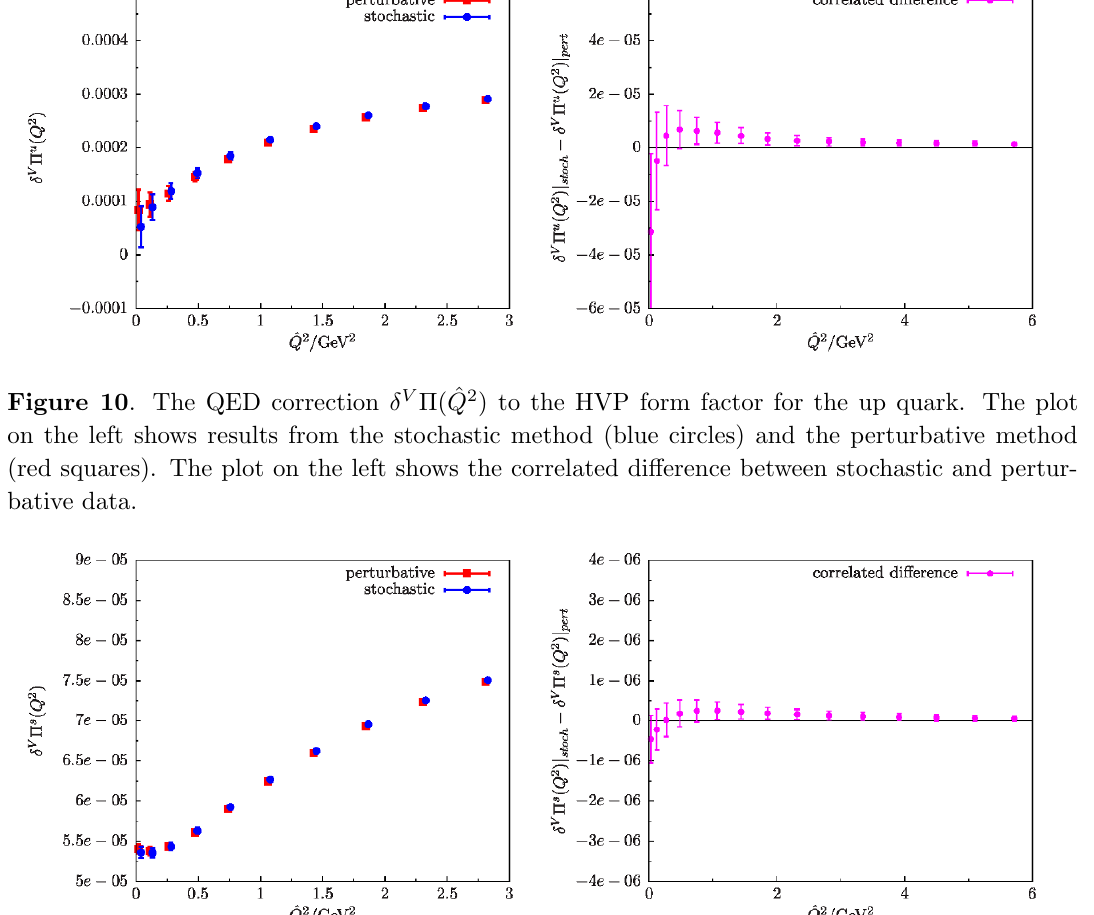
Figure 11 . The same as (cid:12)gure 10 for the strange